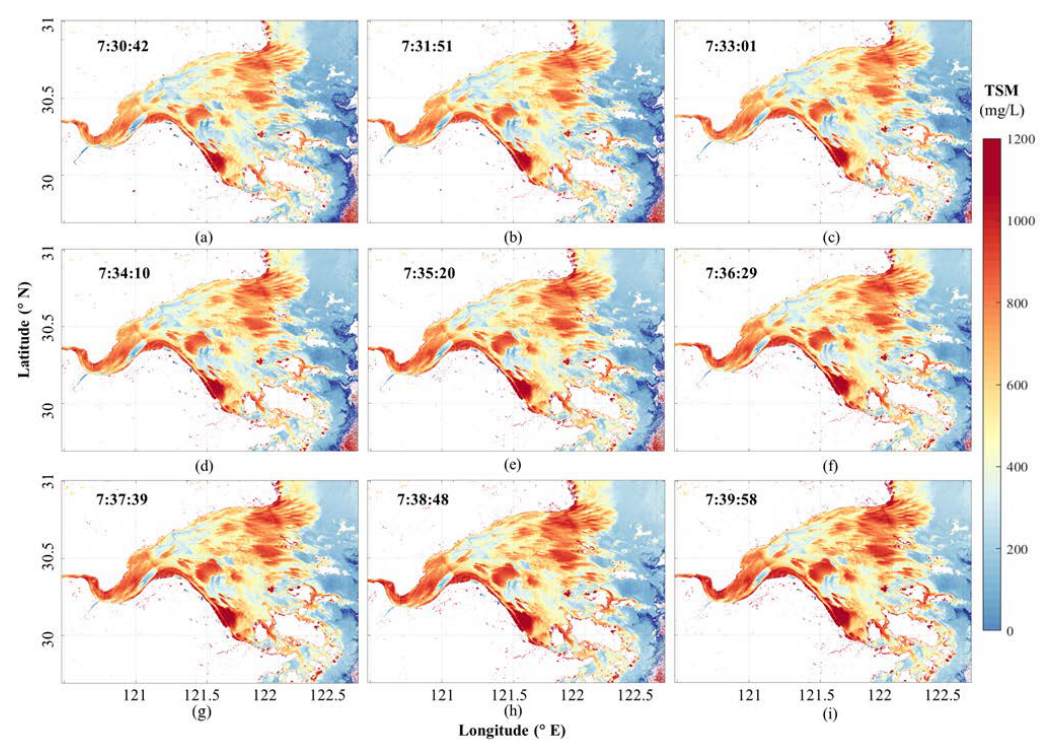
Figure 5. ( a – i ) The per minute spatial distribution of TSM concentration in HZB retrieved by the GF-4 on 28 August 2017. The labeled time in the image corresponds to the observation time in Beijing time.